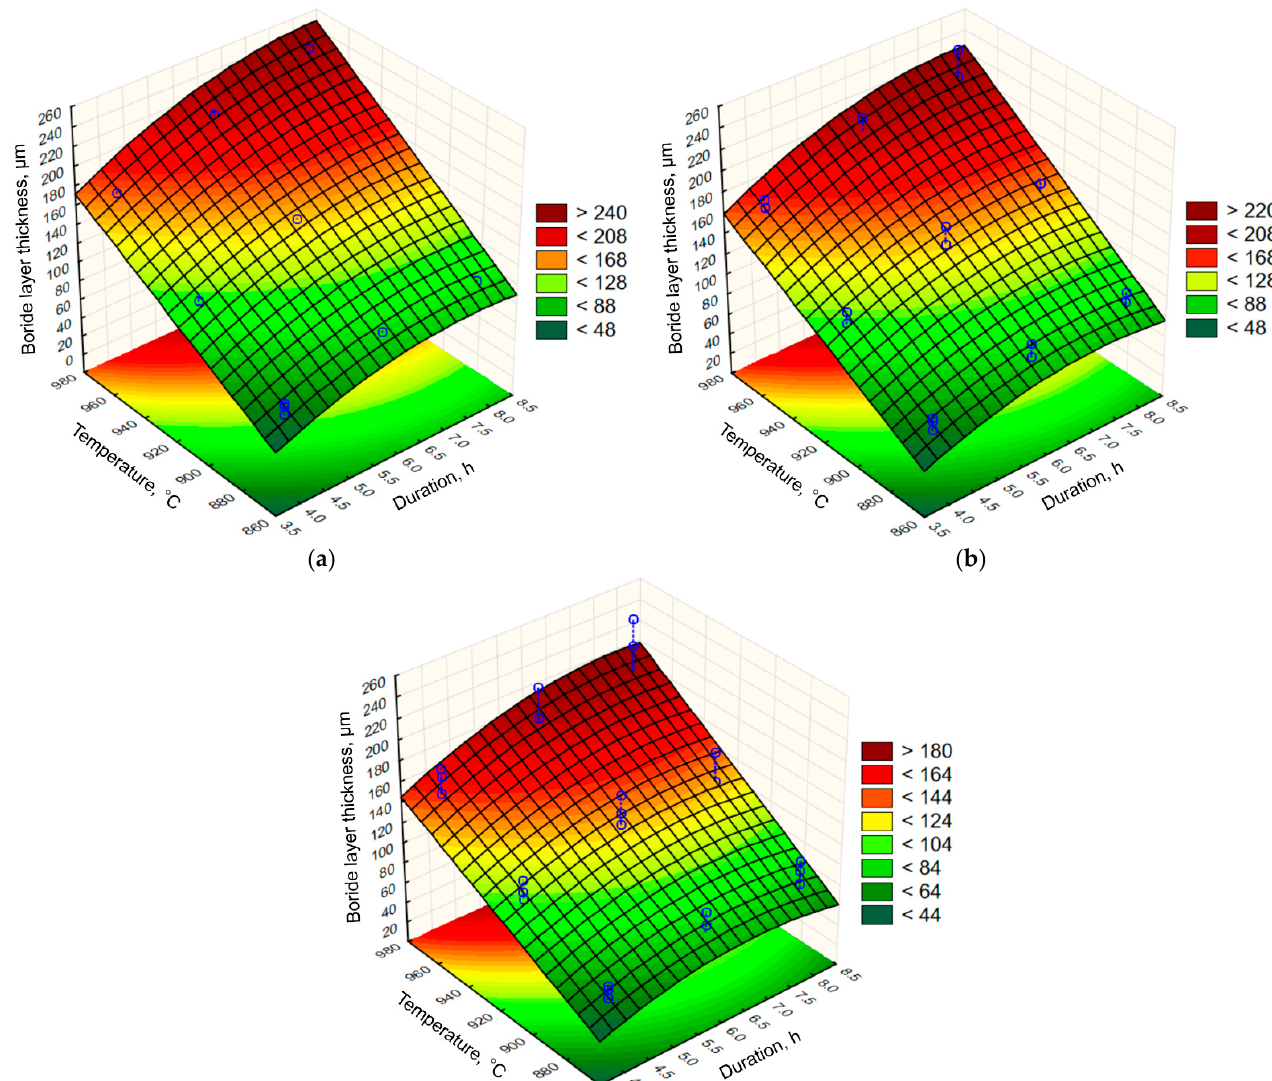
Figure 10. Relation between the boride layer thickness and the boronizing temperature and duration for: ( a ) C15 steel; ( b ) C45 steel; ( c ) C70W2 steel.